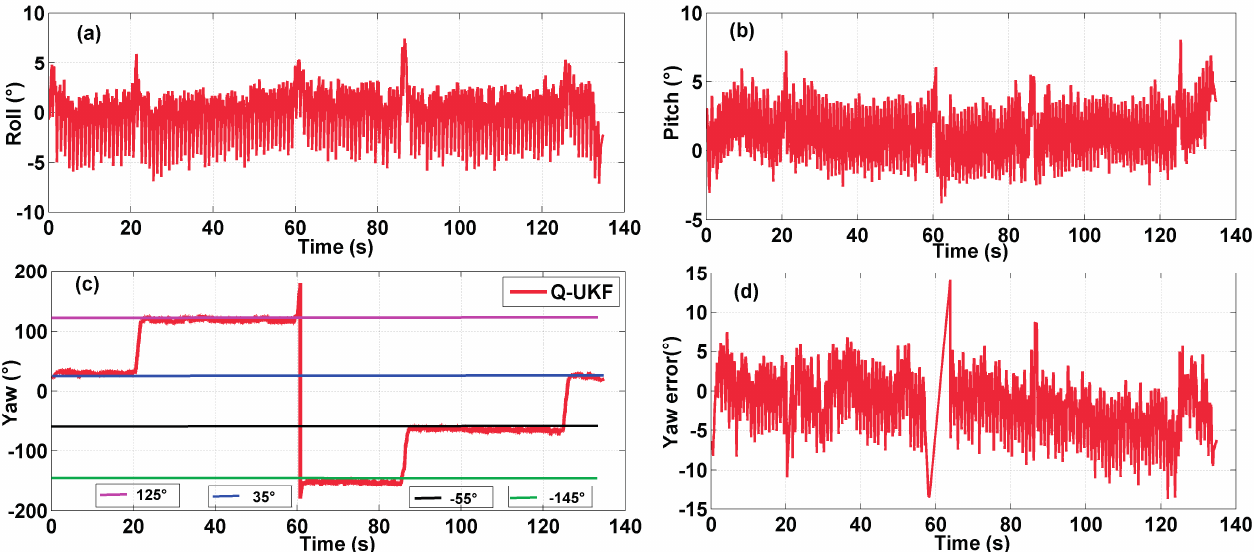
Figure 7. Heading estimation test floor plan ( a ) skeleton map; ( b ) picture of the actual corridor in the position of the circle in (a).